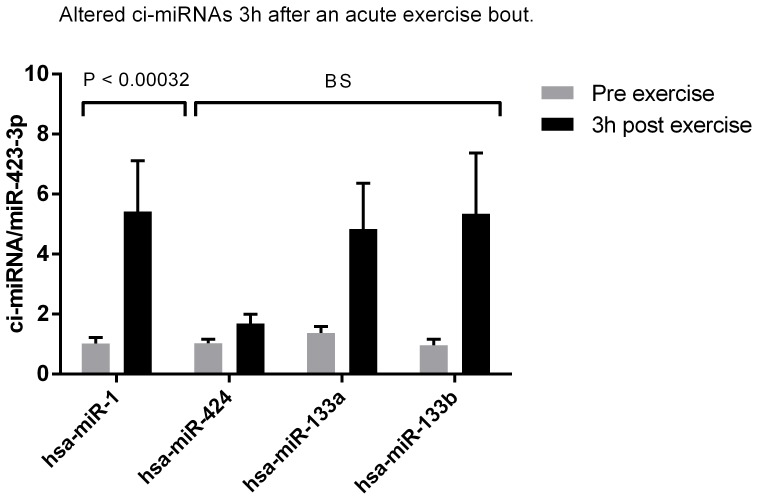
Alterations in ci-miRNAs in plasma three hours after an acute exercise bout.One ci-miRNA was up regulated 3 hour after a 60 min aerobic exercise bout at 65% Pmax when Dunn-bonferroni correction of the significance level 0.05 was performed (P<0.00032). Additional three miRNAs were borderline significant (BS) up regulated at significance level 0.001.